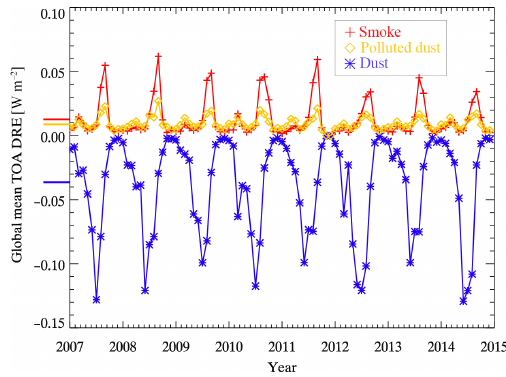
Figure 8. Time series of monthly mean diurnally averaged short- wave cloudy-sky DRE at TOA from 2007 to 2014. The horizontal bars on the y-axis mark the 8-year annual mean